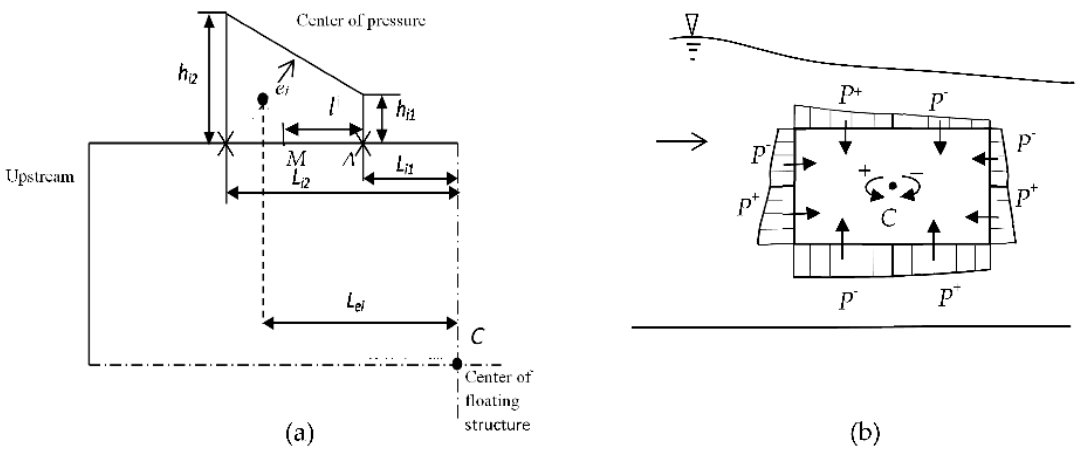
Figure 4. Calculation schematic of the overturning moment: ( a ) Calculation schematic; ( b ) Pressure profile of the measurements.